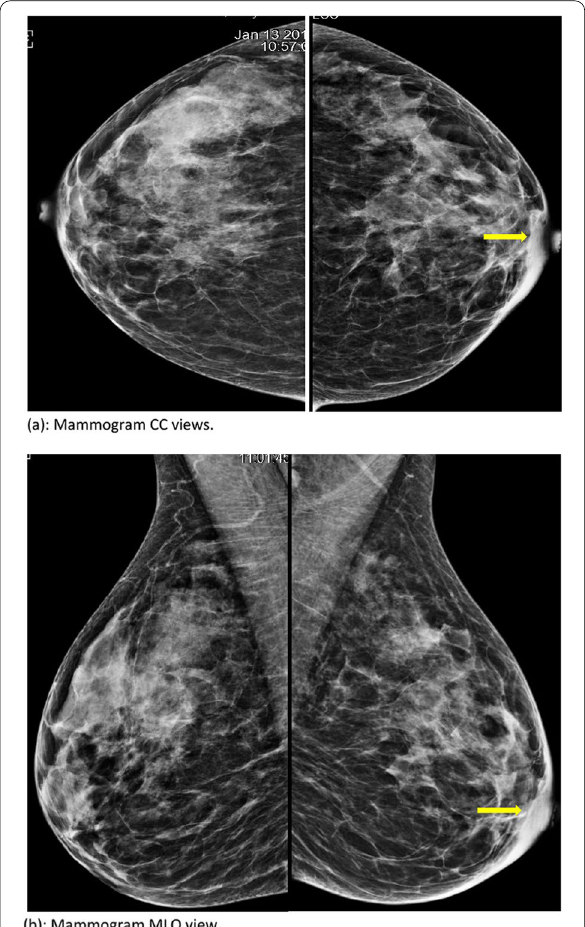
Fig. 1 a Mammogram CC views. b Mammogram MLO view. Focal high-density area in the retroareolar region corresponds to the nodular skin thickening on clinical examination (yellow arrow). There is no mass or microcalcifications in either